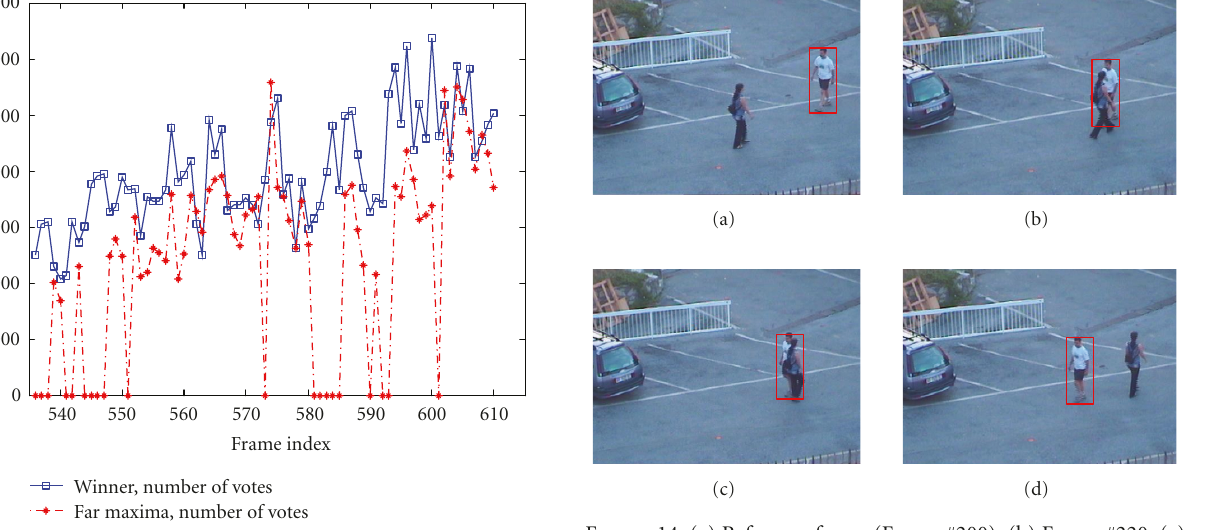
Figure 13: Number of votes for the winner maximum (blue) and for the far maxima (red).